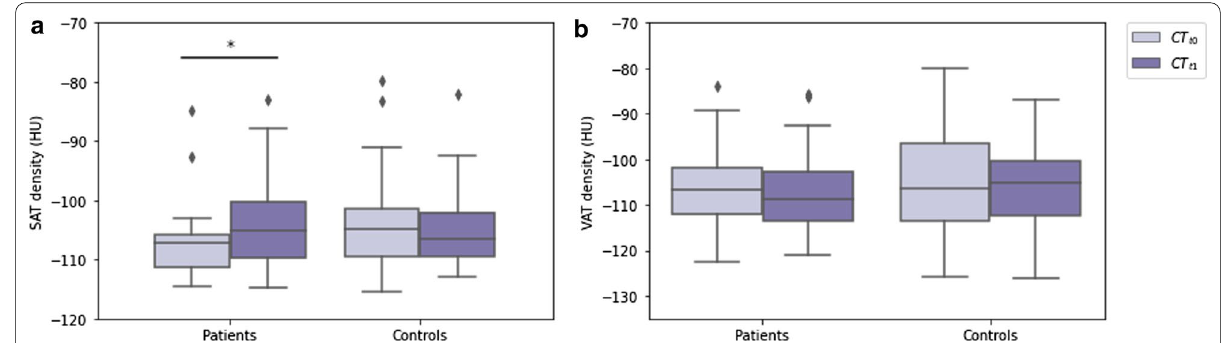
Fig. 5 Boxplots depicting: a the distributions of subcutaneous adipose tissue and ( b ) visceral adipose tissue density at the first (CT-t 0 ) and second (CT-t 1 ) computed tomography examination in patients with breast cancer who underwent treatment with anthracyclines, and in controls with no breast cancer who did not undergo cardiotoxic treatment. * denotes statistical